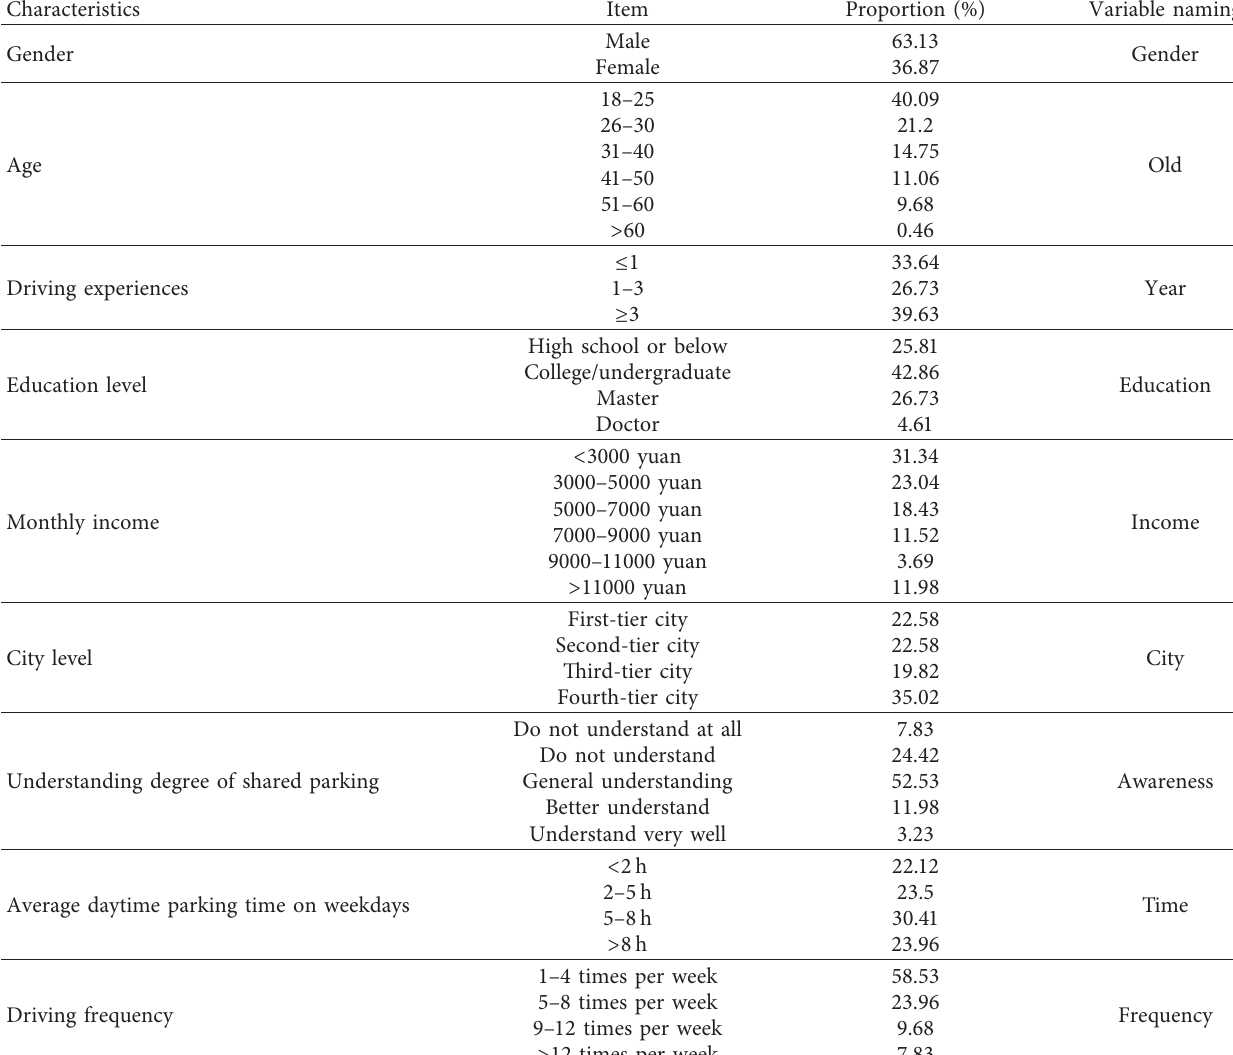
Table 2: Demographic characteristics of the